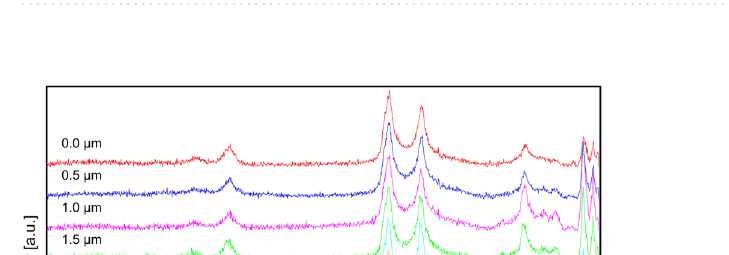
Table 2. The bands observed for Cu 2 O in B7 sample compared with the bands for pure copper oxides.